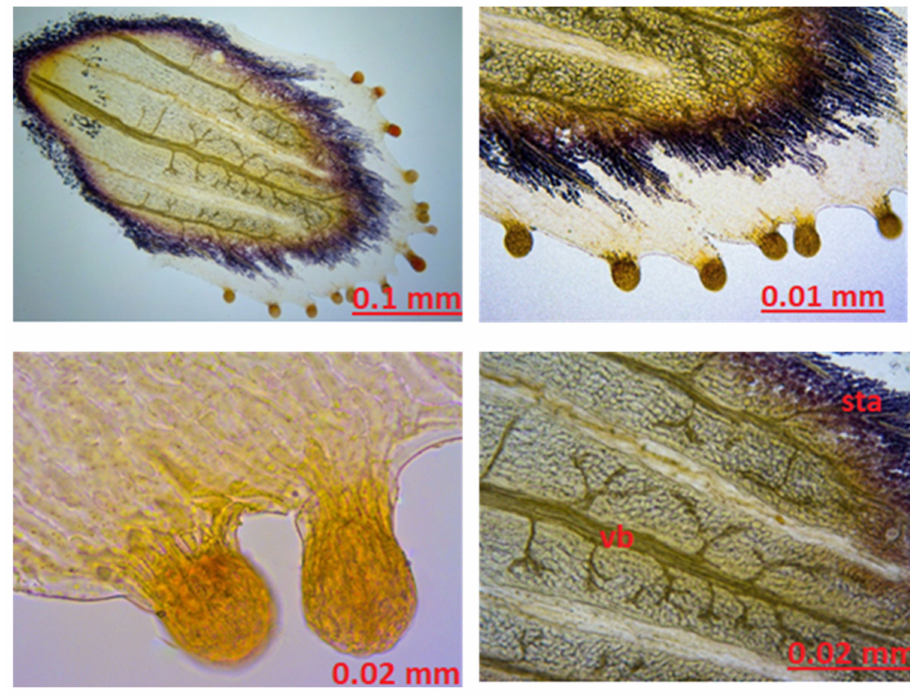
Figure 7. The stamen sepal of Hypericum scabrum ; sta: starch, vb: vascular bundle.